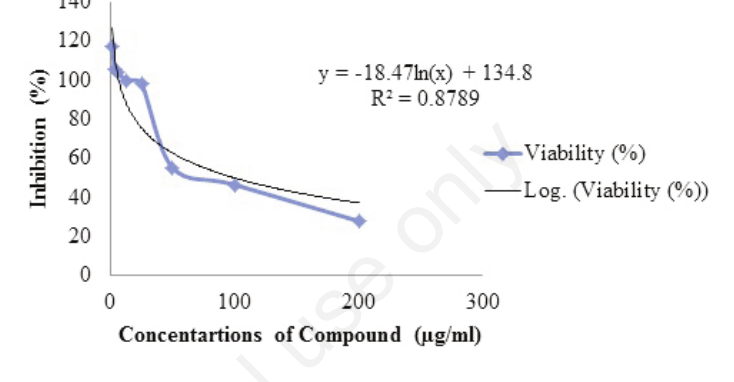
Figure 1. Regression curve of the inhibited DENV-2 after treatment with [Cu(2,4,5-triph- enyl-1 H -imidazole) 2 (H 2 O) 2 ].Cl 2